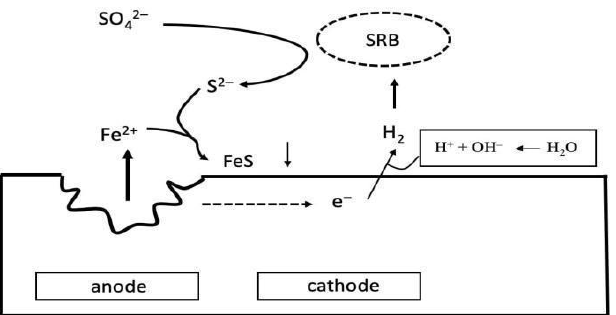
Figure 2. Scheme of iron metal corrosion by SRB (modified from Barton and Fauque, 2009 [2]). SRB consume H 2 , and as a result, depolarize the cathode. When Fe 2+ is released from the anode, a depression is formed in the metal and insoluble FeS is created. H + from ionizing water is combined with electrons to form H 2 for SRB [2].